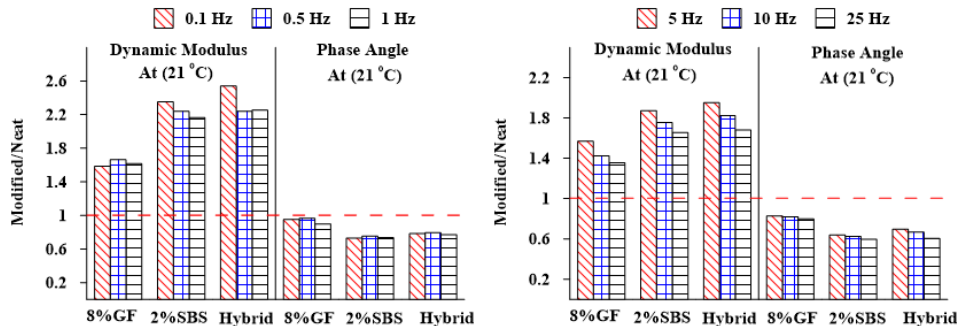
Figure 14. Frequencies’ effects on the E ∗ and δ of different asphalt mixtures at 21 ◦ C.